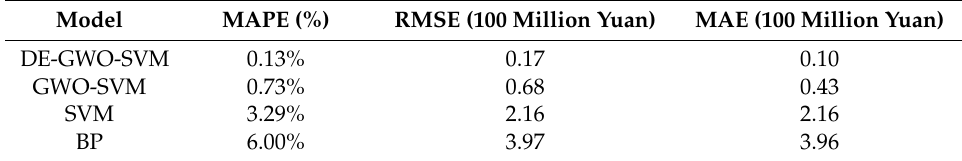
Table 5. The error analysis results.